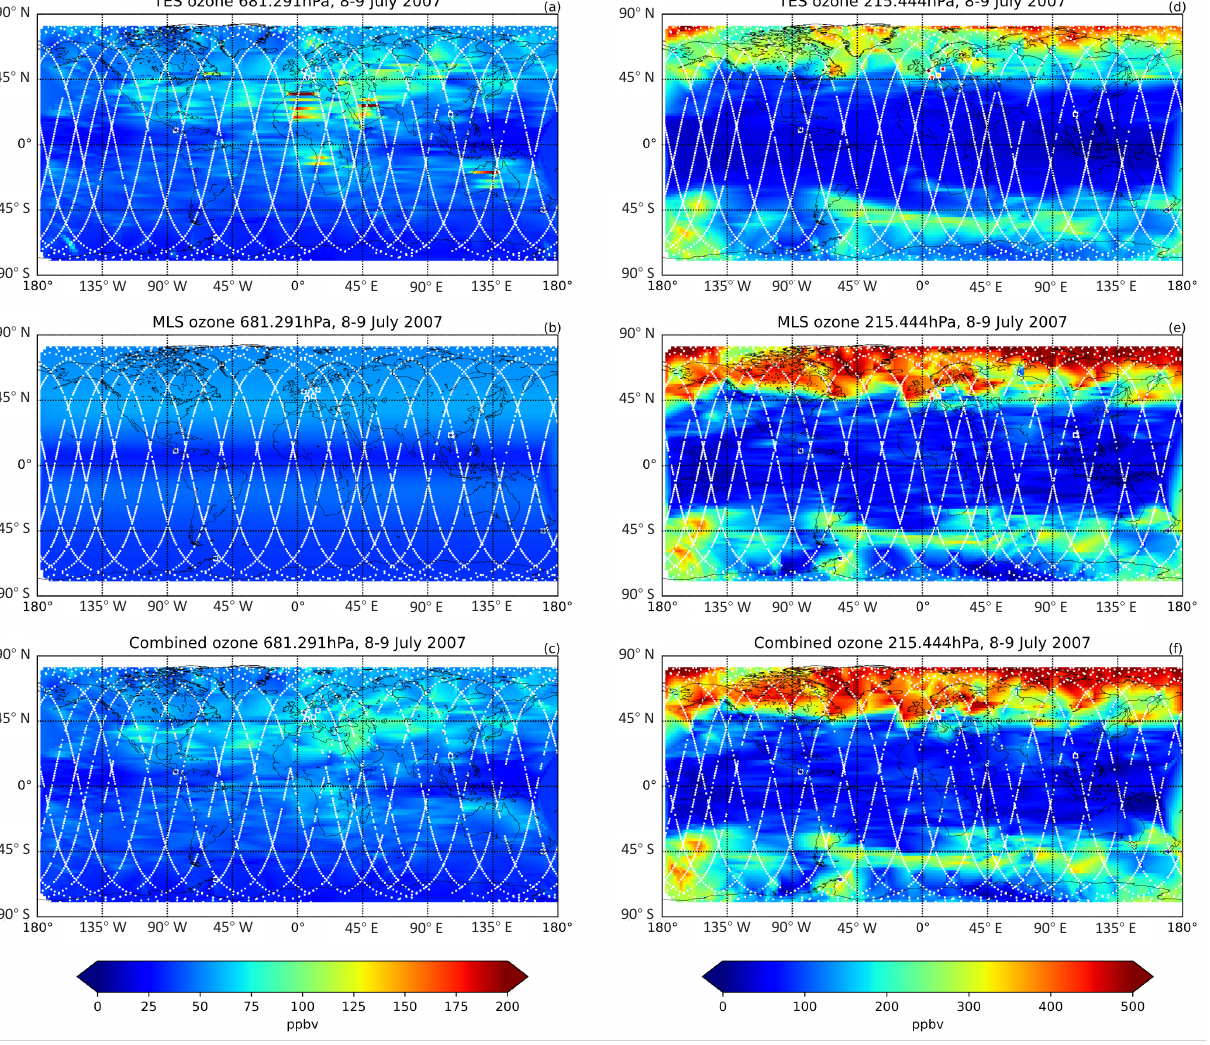
Figure 5. Comparison among horizontal distributions (interpolated) of ozone at 681.291 hPa ( a – c ) and 215.444 hPa ( d – f ) for 8–9 July 2007: ( a , d ) TES product, ( b , e ) MLS product, and ( c , f ) combined product. Locations corresponding to each product are marked by white dots. Colored squares with white edges are ozonesonde